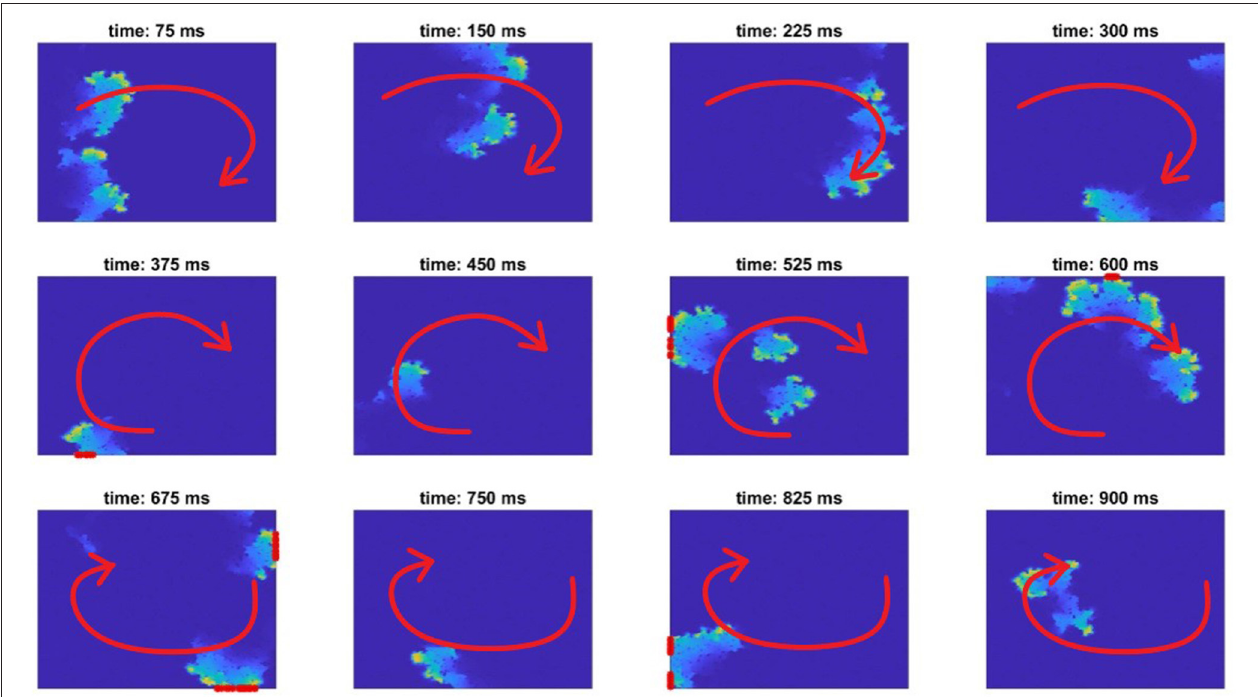
FIGURE 2 | A re-entry formed in fibrotic tissue (red arrow indicates the direction of AP propagation), and its detection. An AP initialised on the left border propagates through the tissue, failing to conduct through the bottom passage. Then, when the excitation turns around (about 250ms), it transmits through this bottom passage and successfully re-emerges into the remainder of tissue, forming a re-entry (about 375ms). Only re-entries that might escape back into the tissue surrounding the afflicted region are counted, as detected by nodes sitting on the boundary of the domain being activated more than one time (marked with a red asterisk on the